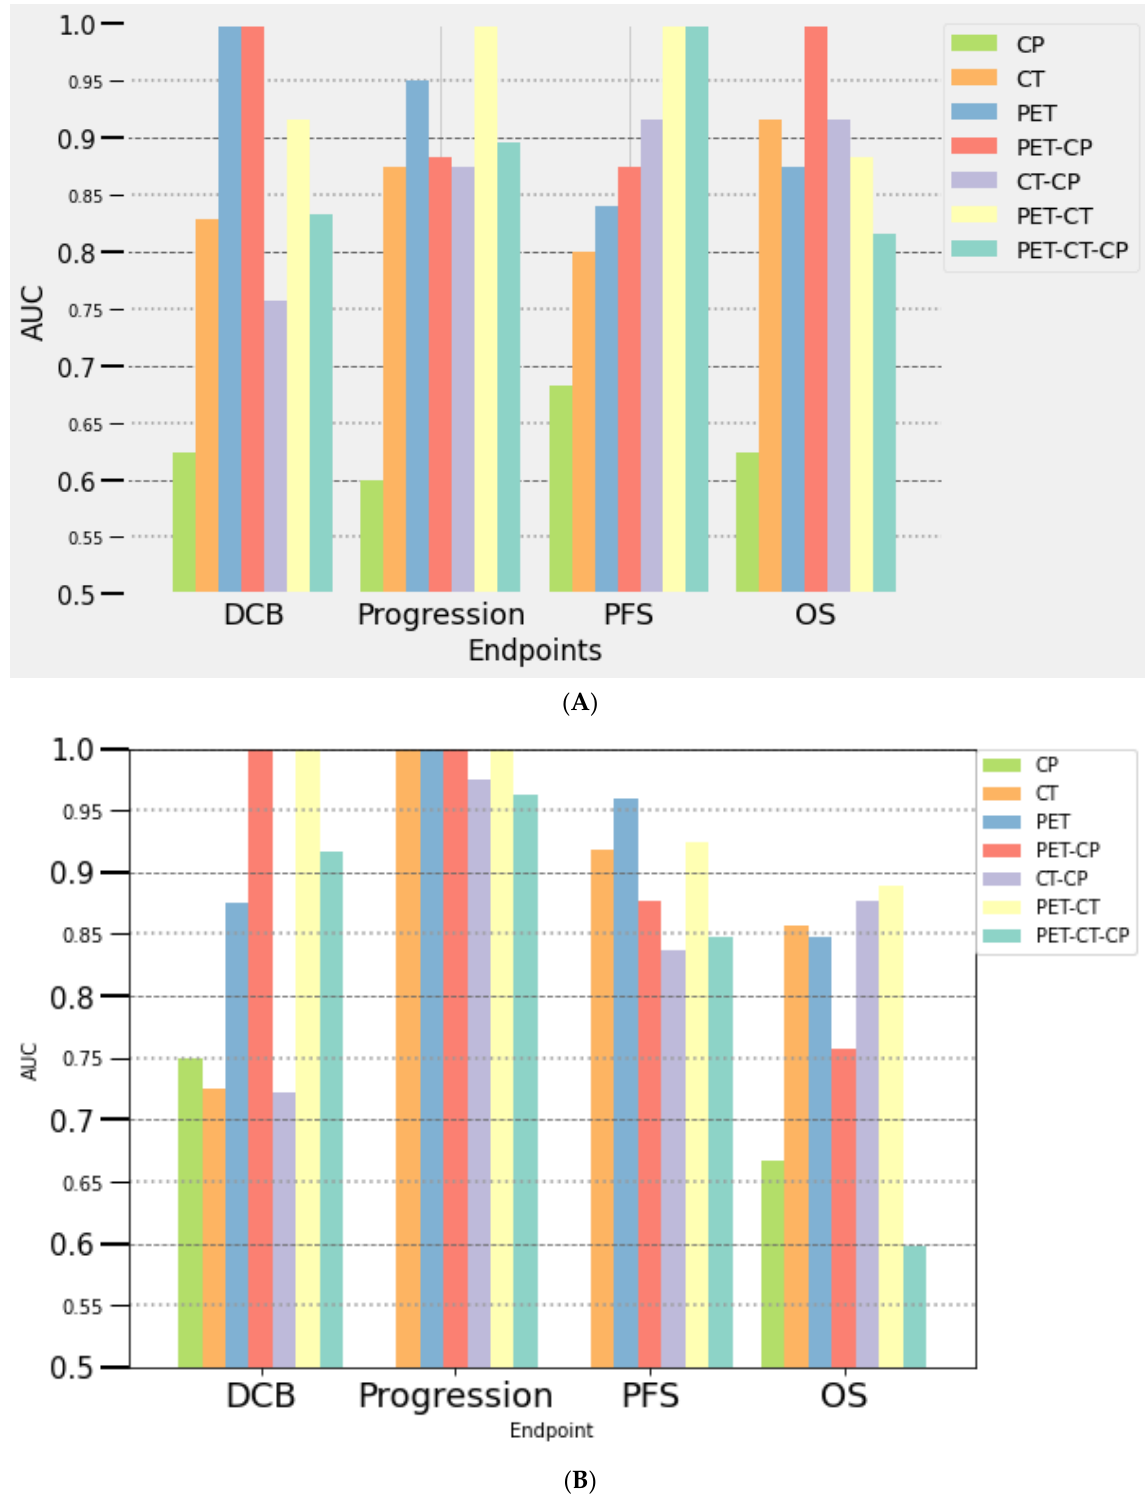
Figure 2. Performances of seven multi-parametric models for the prediction of outcome using clinical data (CP) and radiomics features derived from PET and CT at baseline ( A ) and at month 2 ( B ) in the testing dataset.